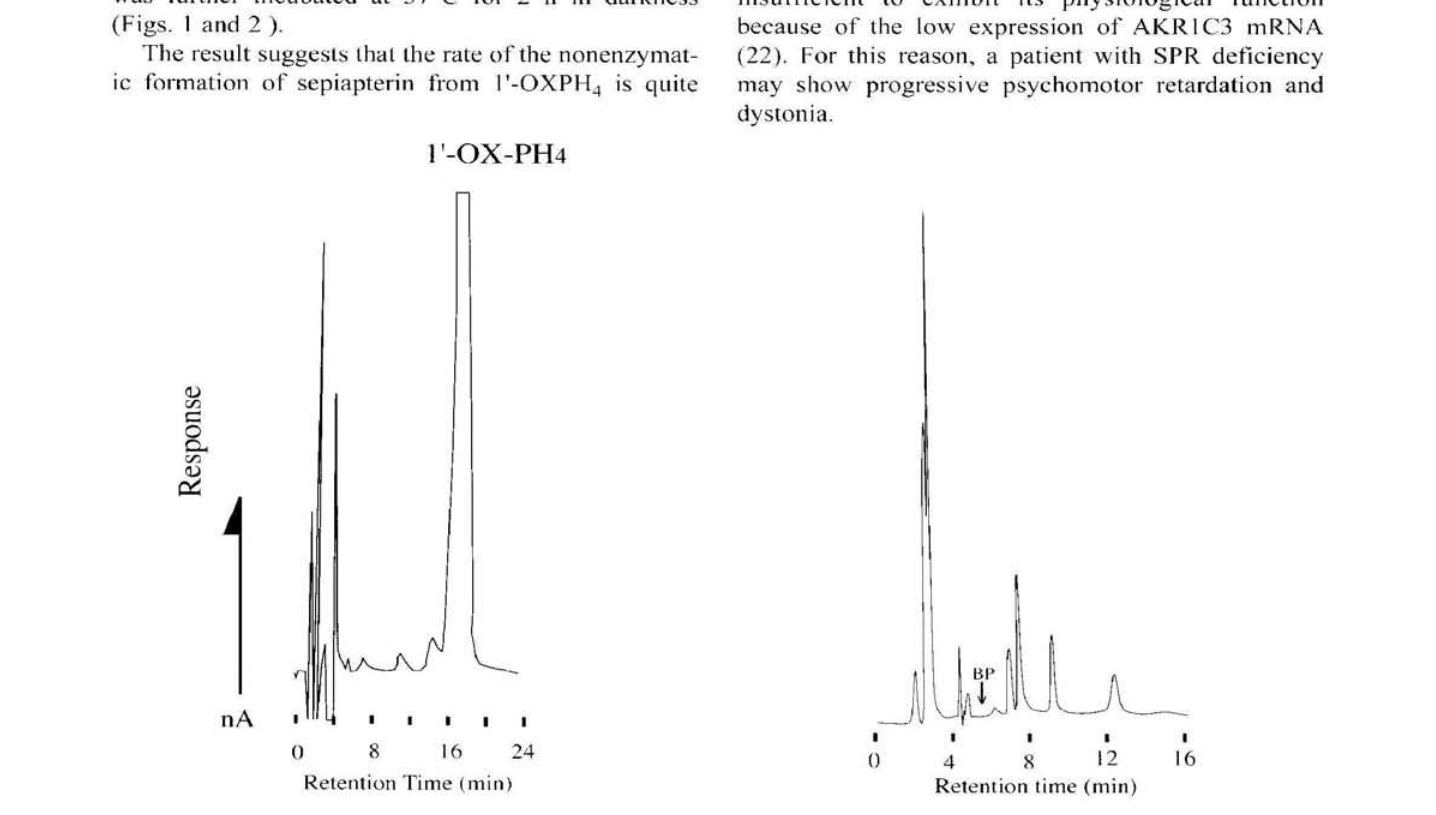
Figure I. Production of l'-OXPH 4 from PPH 4 by CR I. l'-OXPH 4 was analyzed by HPLC with electroche- mical detection. The reaction mixture contained 14 μι M NH 2 TP, 10 μΐ of a concentrated solution of PPH 4 synthase, a 50 μιΜ potassium phosphate buffer (pH 7.0), 8 mM MgCl 2 , 100 μΜ NADPH, and an appropriate amount of CR 1 in a final volume of 100 μΐ. It was flushed with N 2 gas, sealed, and incubated for 60 min at 37 °C in darkness. The amount of l'-OXPH 4 in the resulting reaction mixture was 800 pmol, which was calculated by BH 4 as a standard. small. The present result indicates that the rate of the nonenzymatic conversion of l'-OXPH 4 to sepiapterin is very low, and suggests that the formation of sepi- apterin from l'-OXPH 4 in the proposed pathway is dif- ficult to achieve.